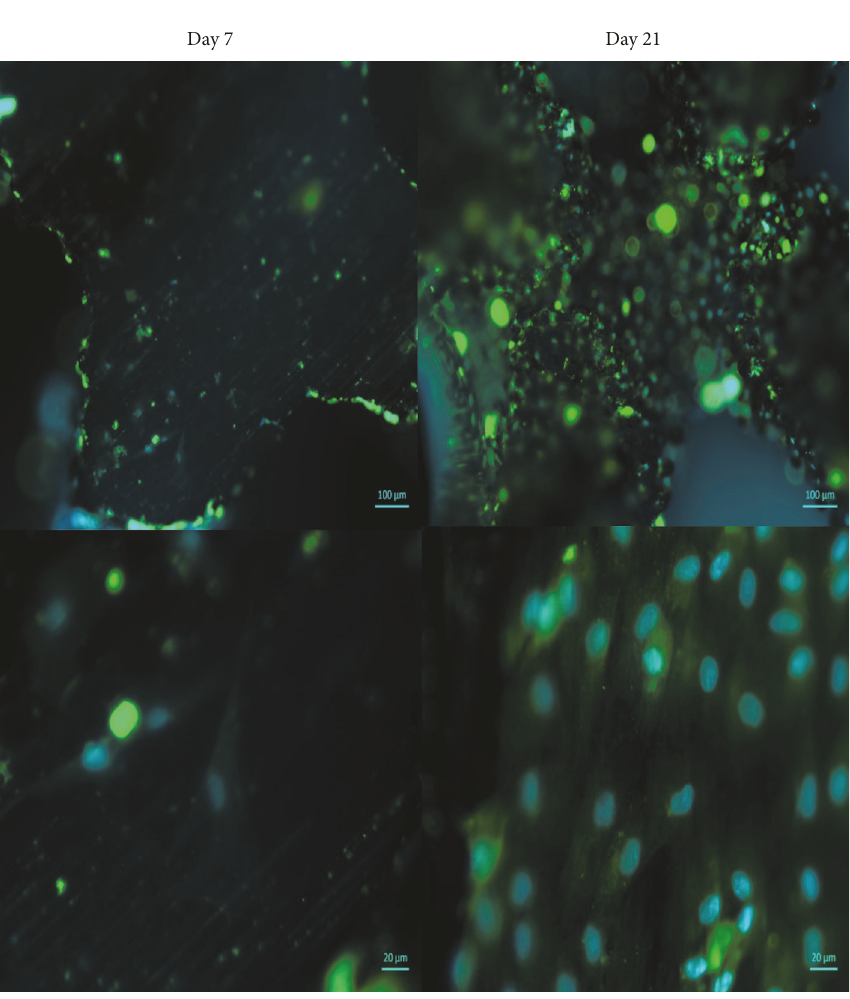
Figure 4: Cell-scaffold interaction; immunostaining of cells on porous noncoated Ti scaffold shows cell nuclei (DAPI, blue) and cytoskeleton (phalloidin, green) at days 7 and 21.